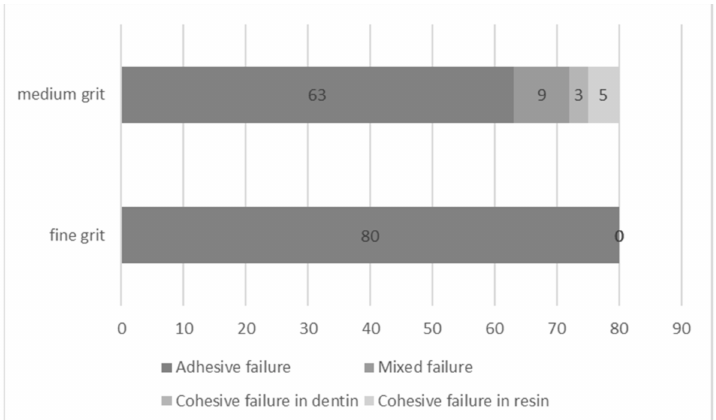
Figure 3. A number of failure modes of specimens prepared with either fine-grit or medium-grit blades are shown. The failure modes are classified into four types: adhesive, mixed, cohesive in dentin, and cohesive in